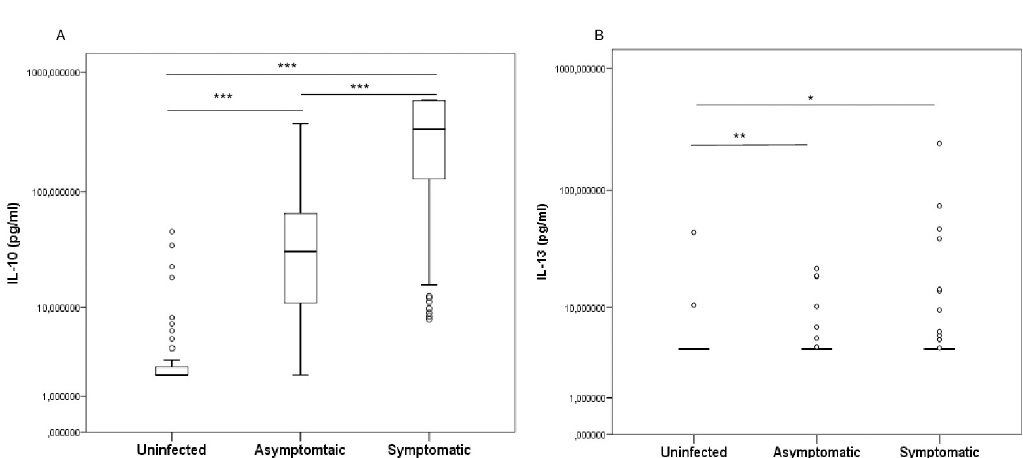
Fig 2. Levels of IL-10 (A) and IL-13 (B) in plasma in children infected with P . falciparum and uninfected children. Concentrations were quantified using enzyme-linked immunosorbent assays (ELISA) and compared between uninfected, symptomatic and asymptomatic children in pairs. Cytokine concentrations were represented by boxplots with median and interquartile range (IQR) in pg/ml on the log10 scale. Statistically significant differences between groups were tested using the Mann–Whitney method and are represented as � p < 0.05; �� p < 0.001; ��� p = 0.0001; ���� p <